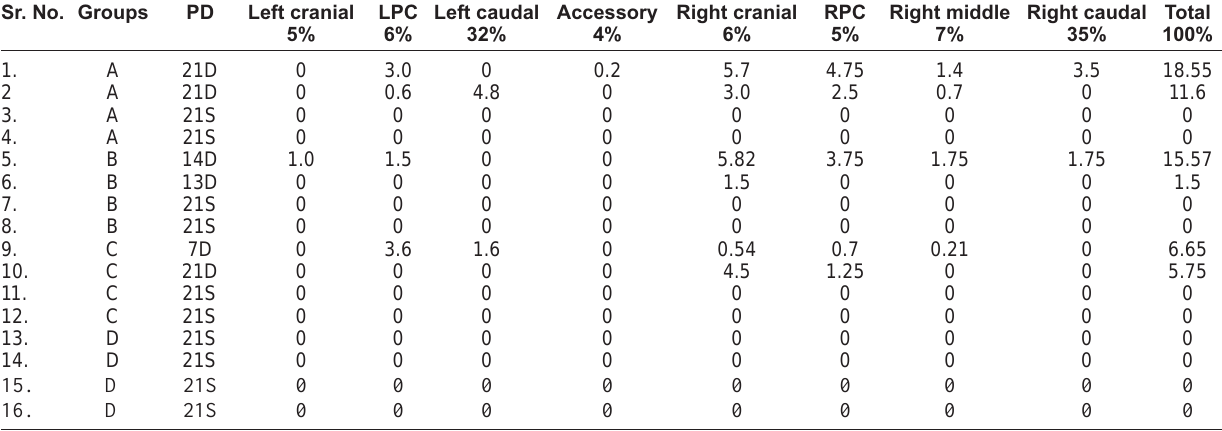
Table-1. Percentage pulmonary consolidation in goats subjected to single and combine dexamethasone treatment and successive road transport stress. Sr. No. Groups